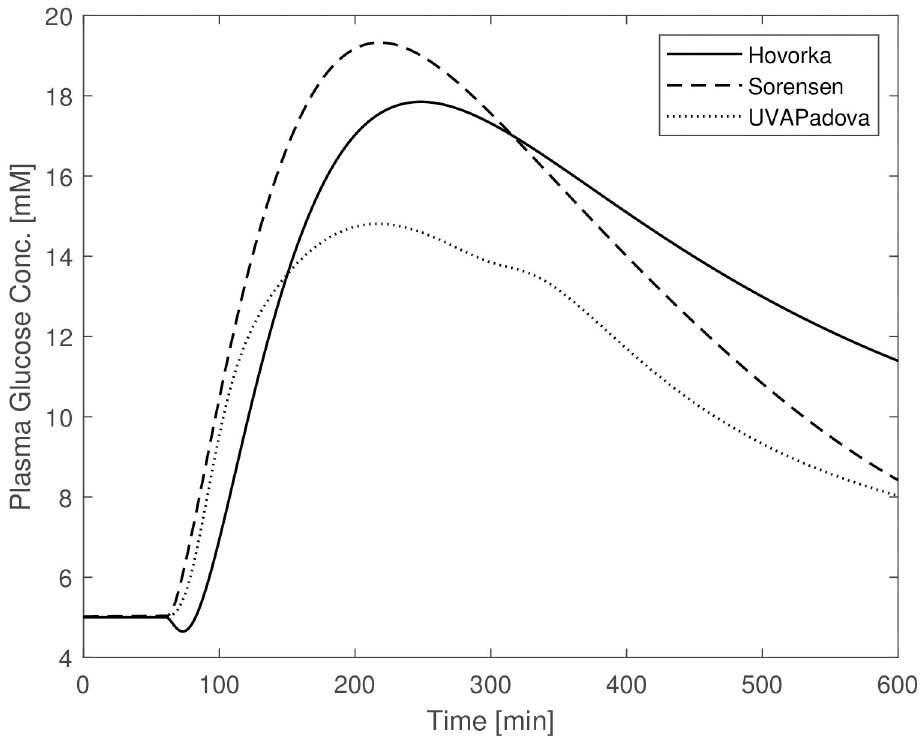
Fig 2. Blood glucose concentrations from the Hovorka (solid line), Sorensen (dashed line) and UVAPadova (dotted line) models with the modified Sorensen model, during an in-silico OGTT experiment in conjunction with an insulin bolus.